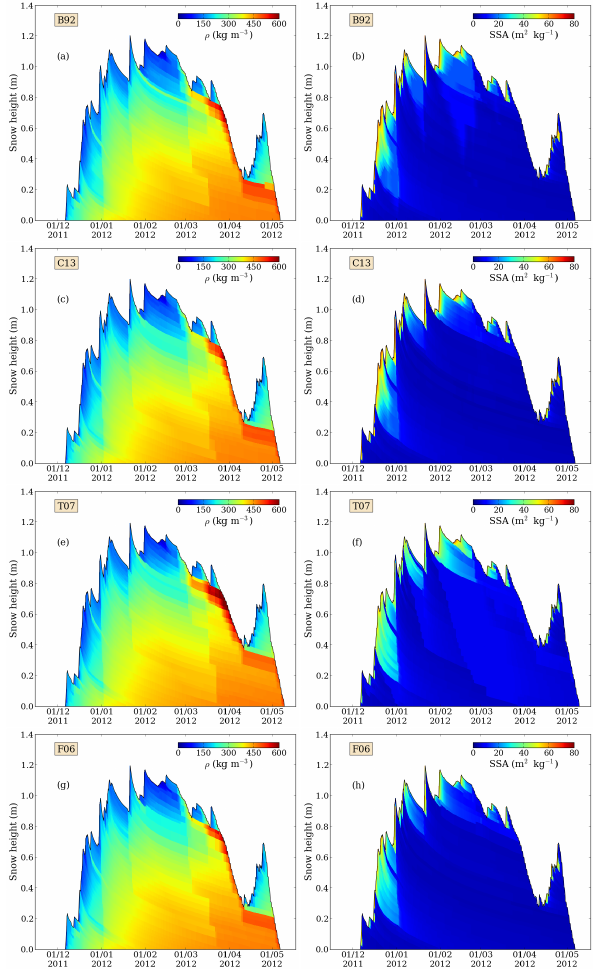
Fig. 11: Simulated density (left column) and SSA (right column) at Col de Porte during winter Fig. 11. Simulated density (left column) and SSA (right column) at 2011/2012. Simulations were run using different metamorphism formulations. From top to bottom: Col de Porte during the winter of 2011/2012. Simulations were run B92(Brunetal.,1992), C13(thiswork), T07(Taillandieretal.,2007)andF06(FlannerandZender, using different metamorphism formulations. From top to bottom: 2006). 39 B92 (Brun et al., 1992), C13 (this work), T07 (Taillandier et al., Fig. 10. Snow height (top), SWE (middle) and surface broadband 2007) and F06 (Flanner and Zender, Fig. 10: Snow height (top), SWE (middle) and surface broadband albedo (bottom) at Col de Porte albedo (bottom) at Col de Porte during the winter of 2011/2012, simulated using four different metamorphism formulations: B92 during winter 2011/2012, simulated using four different metamorphism formulations: B92 (Brun (Brun et al., 1992), C13 (this work), T07 (Taillandier et al., 2007) et al., 1992), C13 (this work), T07 (Taillandier et al., 2007) and F06 (Flanner and Zender, 2006). and F06 (Flanner and Zender, 2006). The black dots in (a) and (b) The black dots in (a) and (b) represent manual weekly measurements and those in (c) represent represent manual weekly measurements and those in (c) represent daily-integrated albedo data. daily integrated albedo data. 38